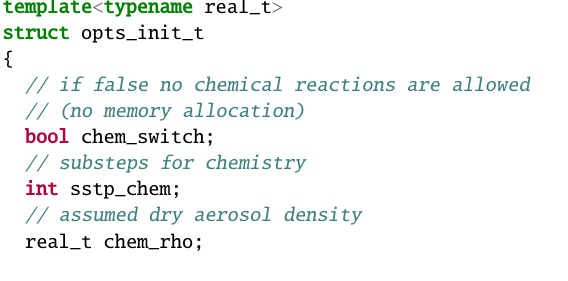
Figure A2. lgrngn::opts_init_t definition.